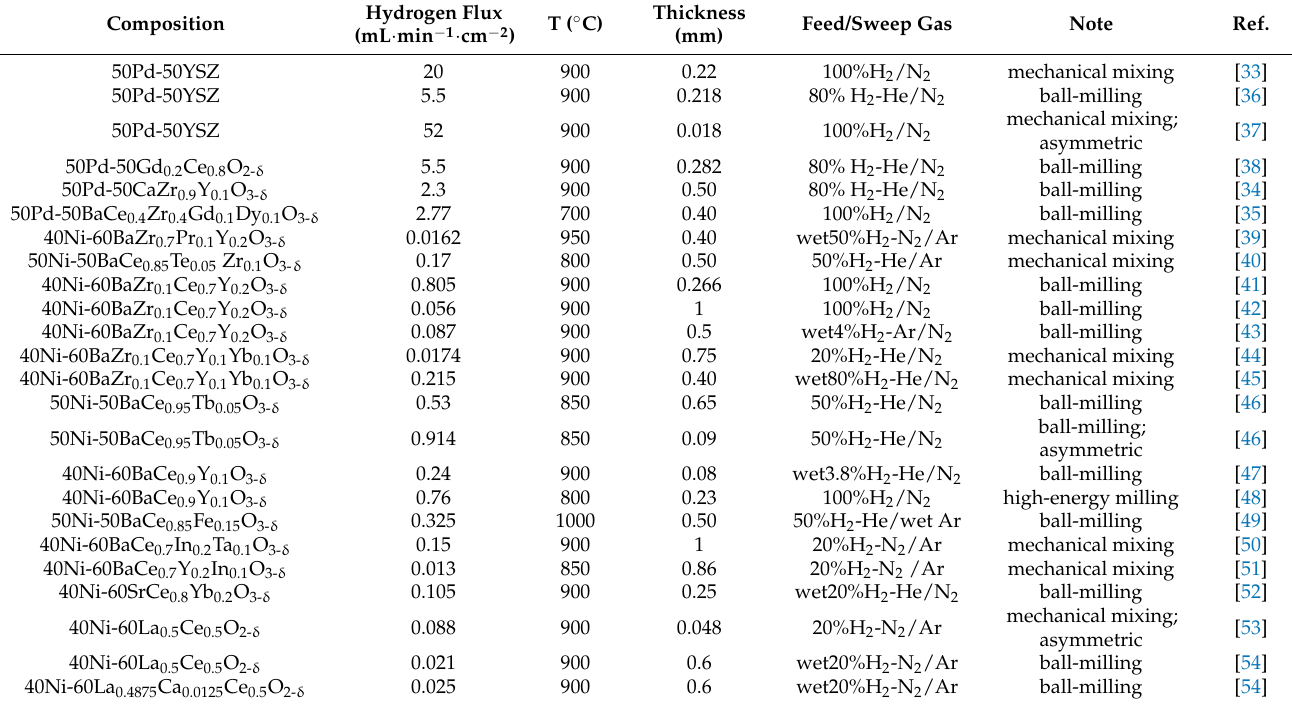
Table 1. Cermet membranes with different hydrogen permeation